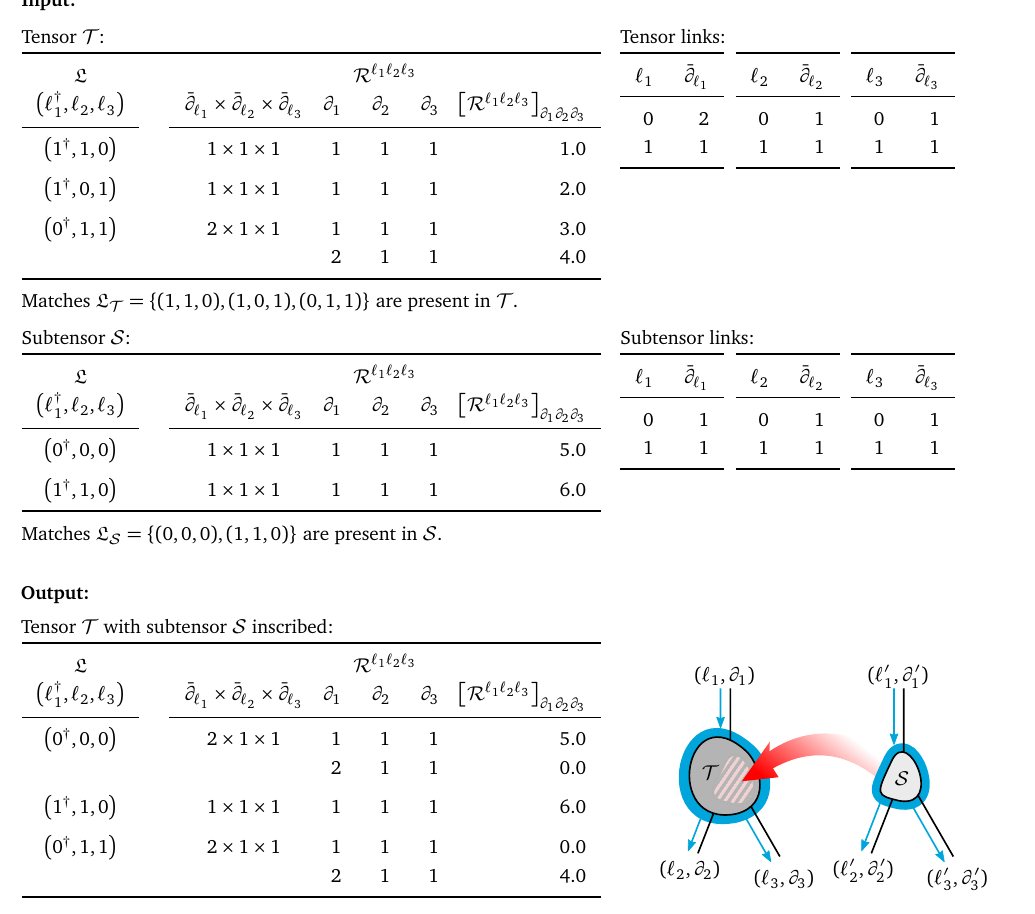
Figure 18: Example of a symmetric subtensor assignment within a three-link tensor T with the same G = Z symmetry and links as in Fig. 15. Top: T and the subtensor 2 S come with similar symmetry and number of links, but the second degeneracy = 2 has been removed from the degeneracy subspace D index ∂ (cid:96) = 0 of the invariant 1 1 quantum number in the first subtensor link. This is an exemplary link-index reduction, mapping all the lower degeneracy indices (here ∂ ≡ 1 ) from S onto the same indices ( ∂ ≡ 1 ) in T . Bottom: Output tensor T after assignment, with all elements from S inscribed into respective subtensors of T